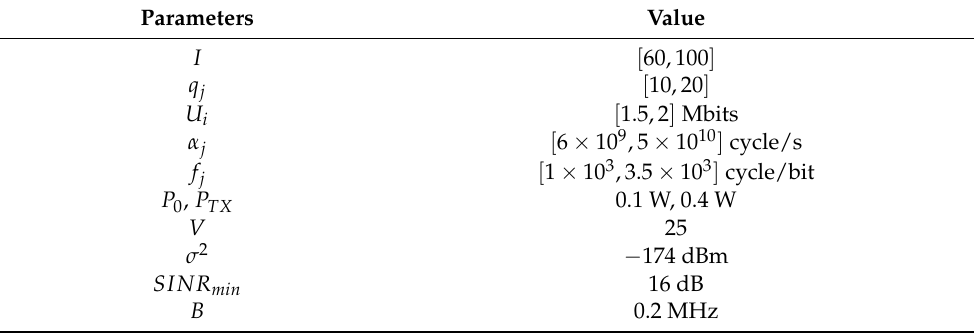
Table 1. Simulation